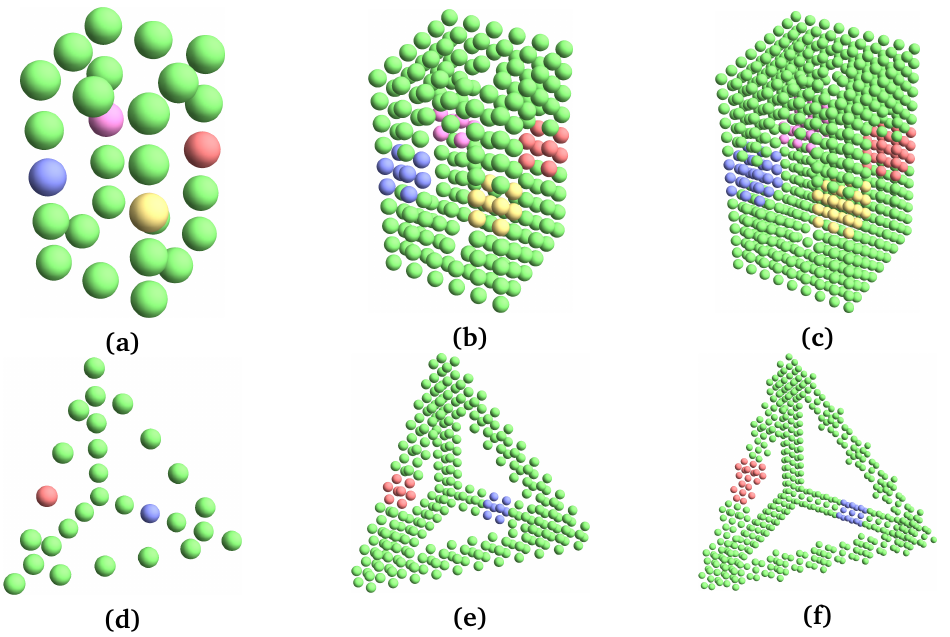
Figure 6: Geometries used to check Table 1 on a computer. Each point represents a unit cell of the lattice model that is included in the subsystem of the given color. (a-c) Lattice implementations of the cubic I ( A ; B ; C ; D | E ) scheme for three different sizes of subregions. The cubic and triangular-prism I ( A ; B | C ) scheme implementations are similar. (d-f) Lattice implementations of the tetrahedral I ( A ; B | C ) scheme. Since we used stabilizer models, no entry in Table 1 depended on the subsystem